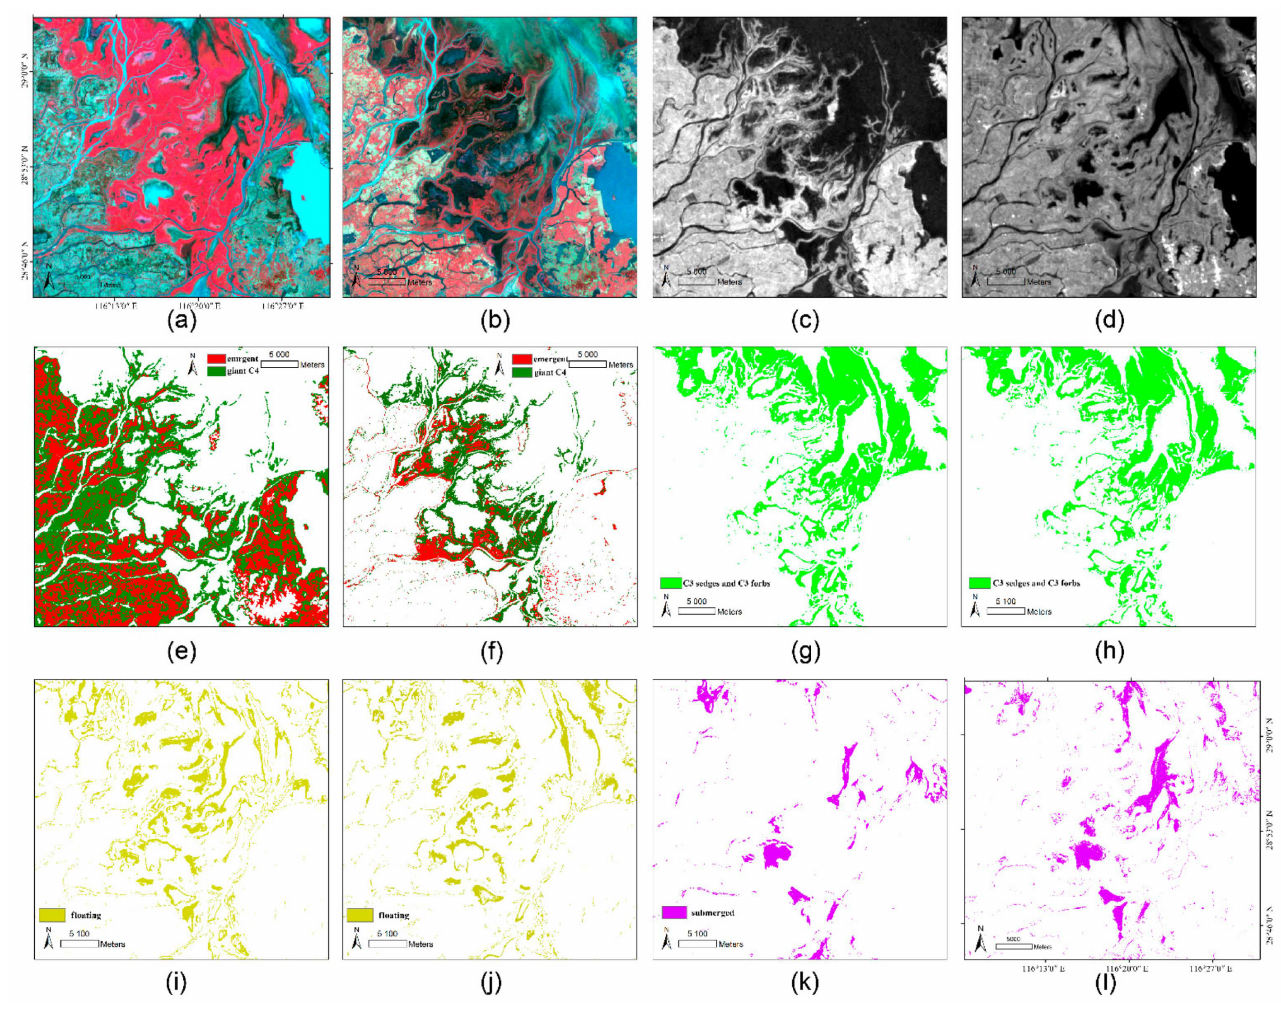
Figure 8. Beijing-1 images comprising first component of summer ASAR WSM PCA analysis and maps of five main PFTs from two classification methods. ( a , b ) Beijing-1 images acquired on 19 April and 17 October 2007, respectively; ( c , d ) PCA analysis of first component of summer and winter ASAR WSM image; ( e , f ) classification results of emergent aquatic macrophytes and giant C4 grasses by decision tree and rule-based methods; ( g , h ) classification results of C3 (sedges and forbs) by decision tree and rule-based methods; ( i , j ) classification results of floating aquatic macrophytes by decision tree and rule-based method; ( k , l ) classification results of submerged aquatic macrophyte by decision tree and rule-based methods.